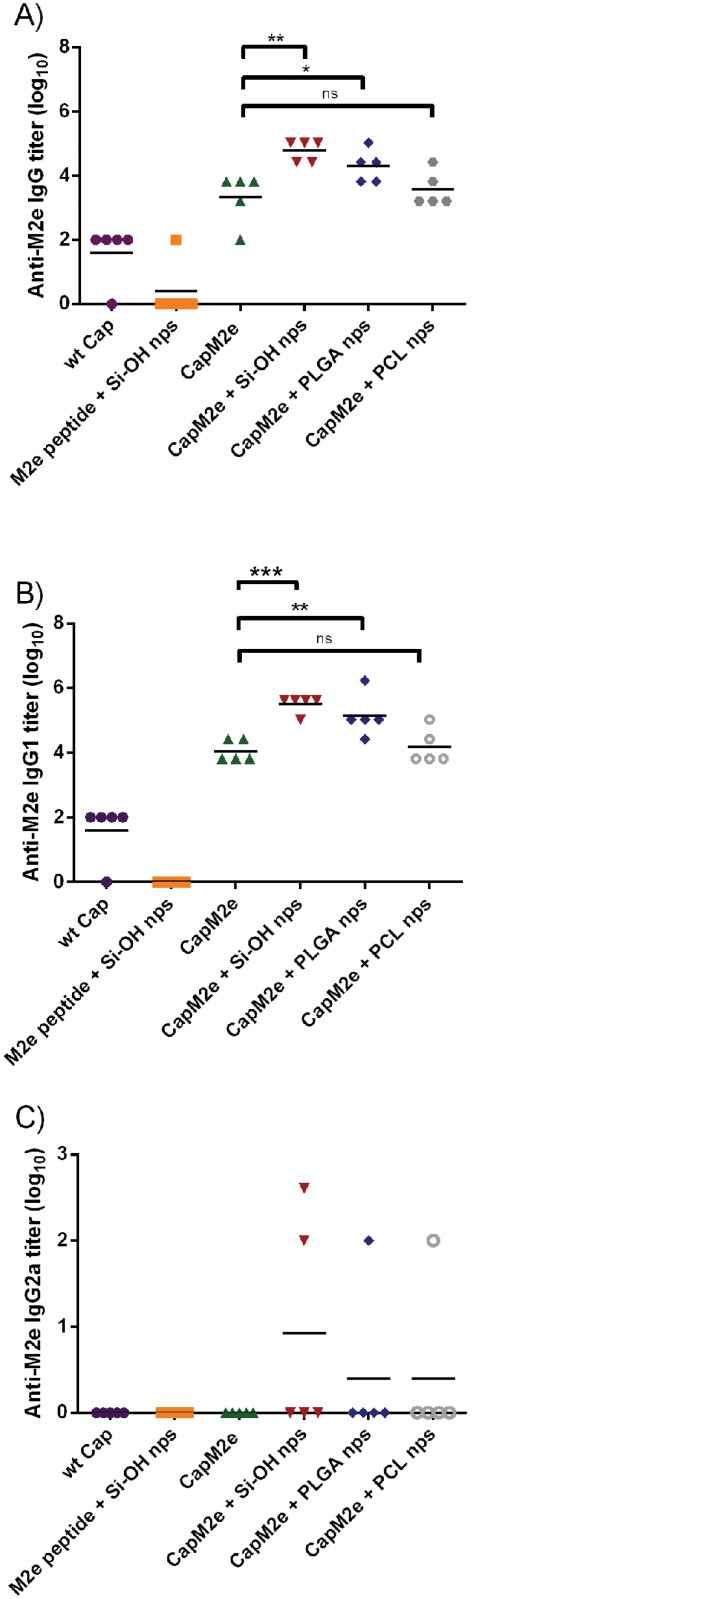
M2e-specific antibody titers in BALB/c mice following three subcutaneous immunizations with different formulations.A) Total IgG, B) IgG1, and C) IgG2a. *, p<0.05; **, p<0.01; ***, p<0.001; ns = not significant.